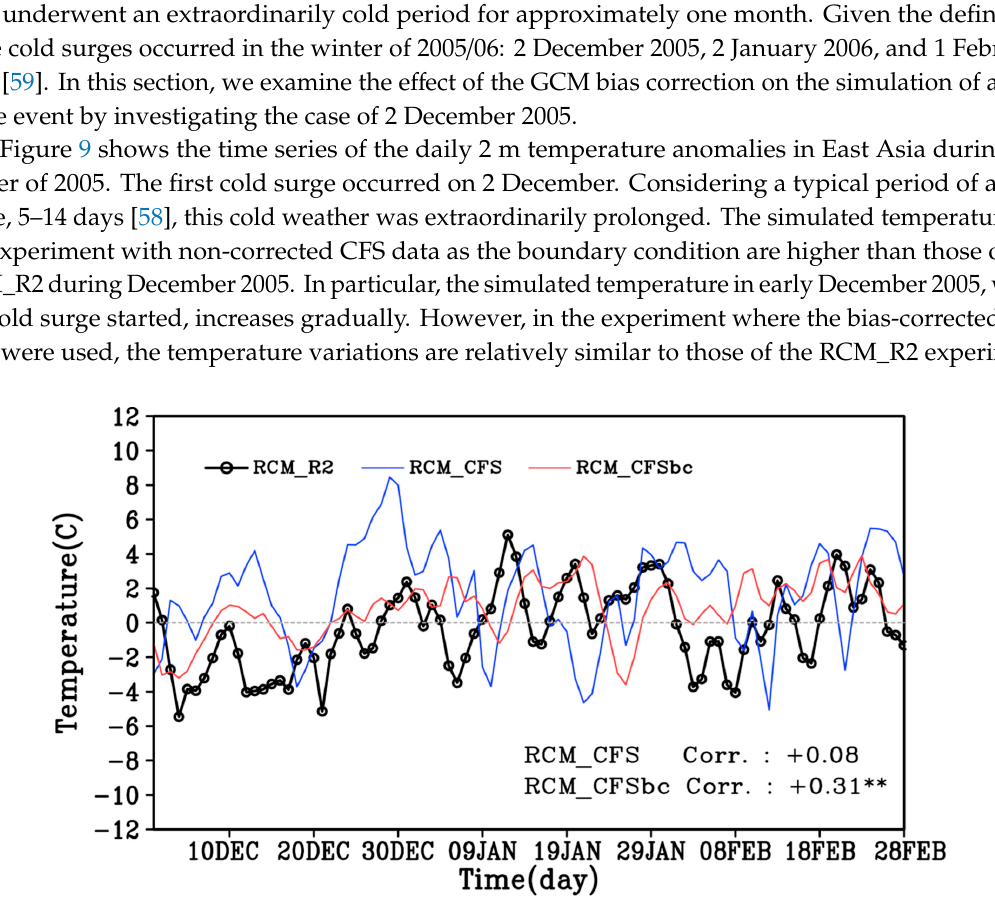
Figure 9. Time series of daily anomaly of 2 m temperature for RCM_R2 (black line), RCM_CFS (blue line), and ( c ) RCM_CFSbc (red line) experiment during DJF 2005/06 over East Asia (110° E–130° E, 20° N–45° N). Correlation coefficients are also shown at the bottom right in the figure and ** indicates significance at the 99% confidence level.